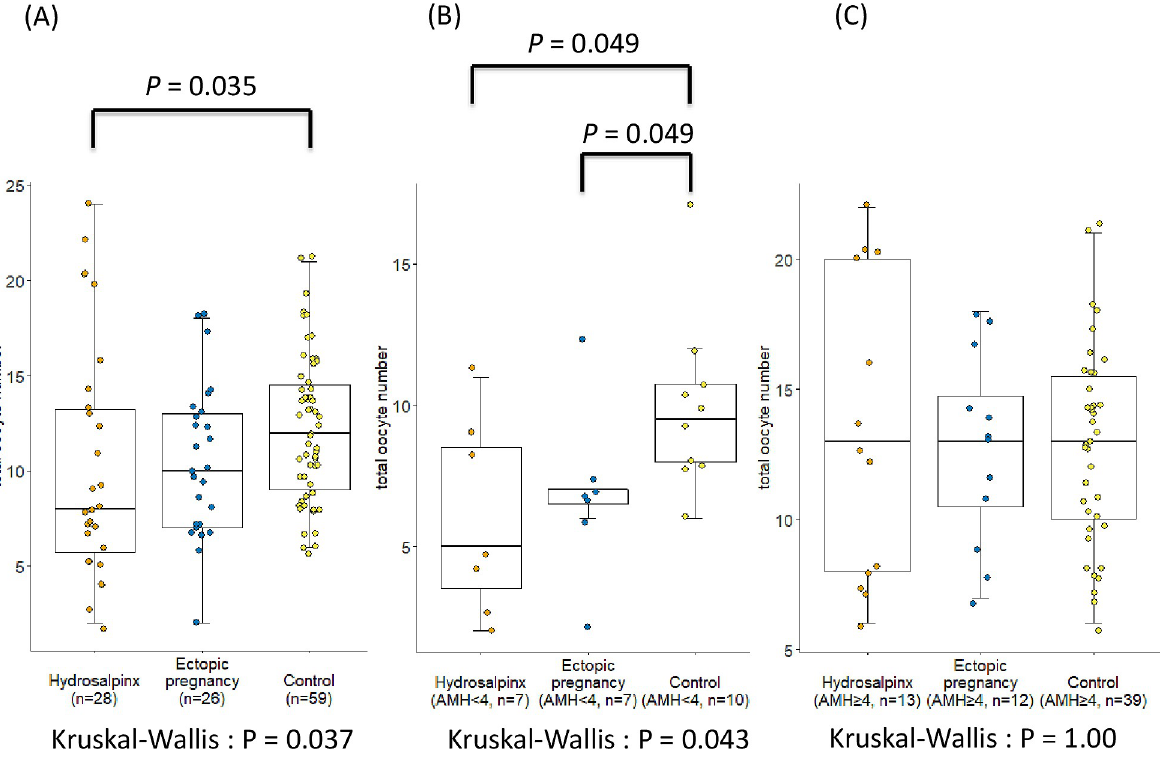
Fig 2. Total number of retrieved oocytes in women with distinct indications of salpingectomy. Comparison of the differences in the numbers of retrieved oocytes between women without tubal disease (control) and women with different indications for prior salpingectomy (i.e., hydrosalpinx and ectopic pregnancy) (A) in all enrolled participants, (B) in women with AMH < 4 ng/mL, and (C) in women with AMH � 4 ng/mL. Values were provided in the minimal data set of supplementary files. Statistical analysis was by Kruskal–Wallis test with the Hochberg post hoc testing. AMH: anti-Mu¨llerian